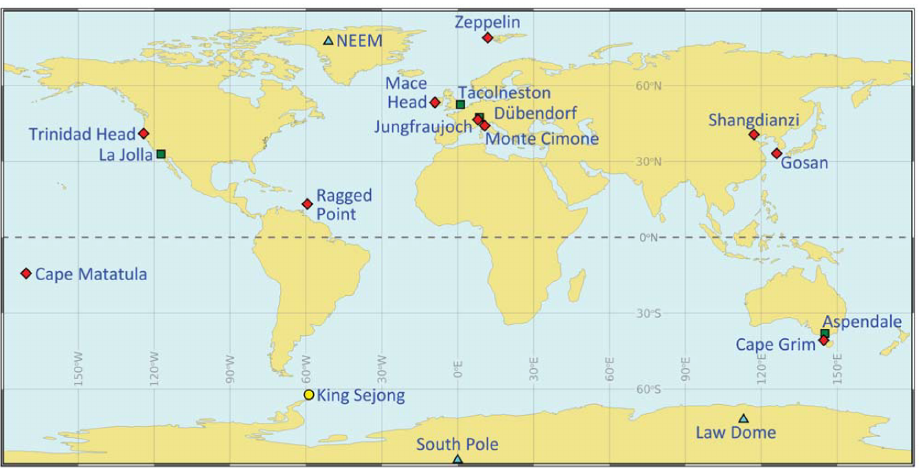
Figure 1. Sampling locations for the chlorofluorocarbons CFC-13, (cid:54) CFC-114, and CFC-115 used in this analysis. Filled red diamonds are field sites of AGAGE (Advanced Global Atmospheric Gases Experiment) and related networks, green filled squares are urban sites, the cyan triangles denote the sampling stations for the firn air samples, and the yellow filled circle is for the flask sampling site King Sejong,